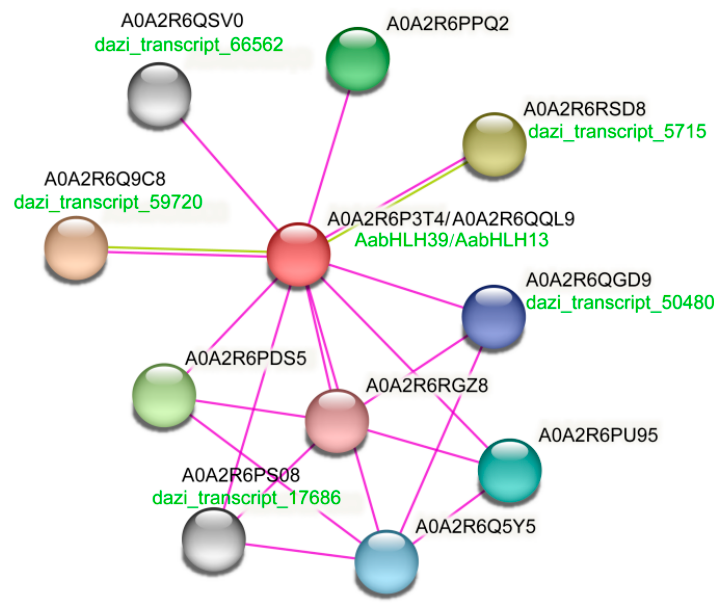
Figure 7. Protein interaction network for the candidate anthocyanin biosynthesis-related AabHLHs according to bHLHs orthologs in A. chinensis .